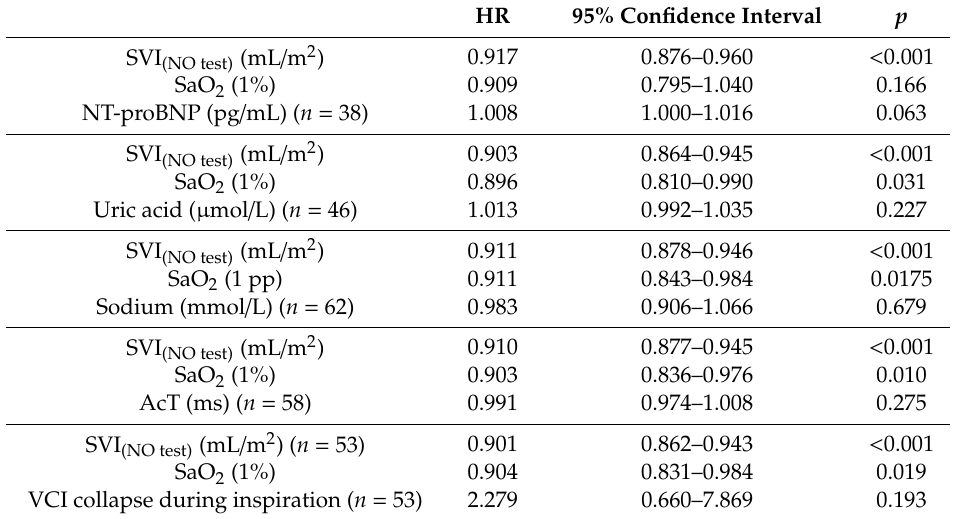
Table 9. Three-variable Cox regression analysis of incomplete data (NT-proBNP, uric acid, sodium, AcT, VCI collapse during inspiration).